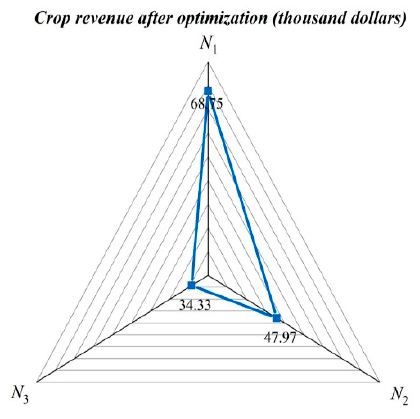
Figure 6. Crop revenue before optimization.